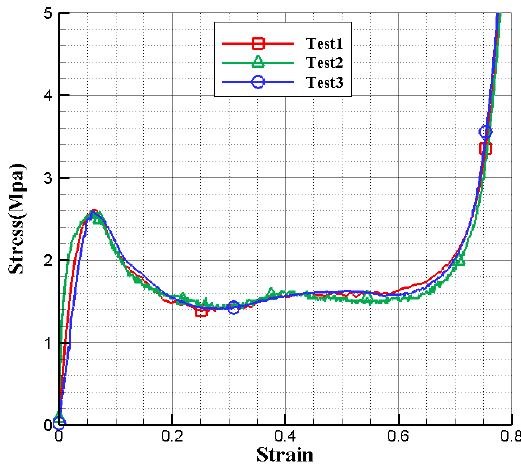
Figure 14. Stress–strain curve at strain rate 4.6 × 10 3 s − 1 .